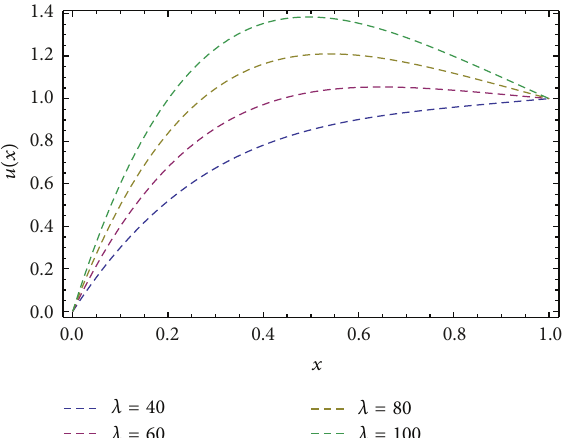
Figure9:Theinfluenceofthedimensionless“ 𝜆 ”onthetemperature distribution for lift problem keeping, 𝛼 = 0.5 , 𝛽 = 0.2 , 𝑀 = 2 , and 𝑚 = 1 .